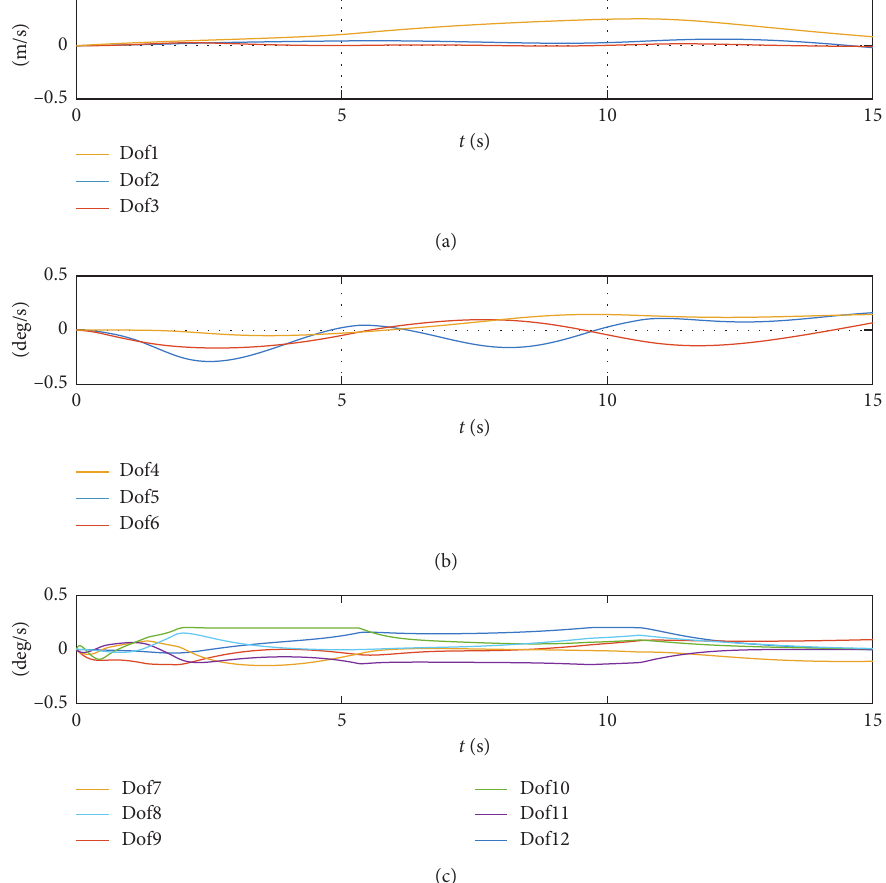
Figure 12: Speed variation process of the UVMS driven by the proposed method. (a) Vehicle velocities. (b) Vehicle angular velocities. (c) Joint